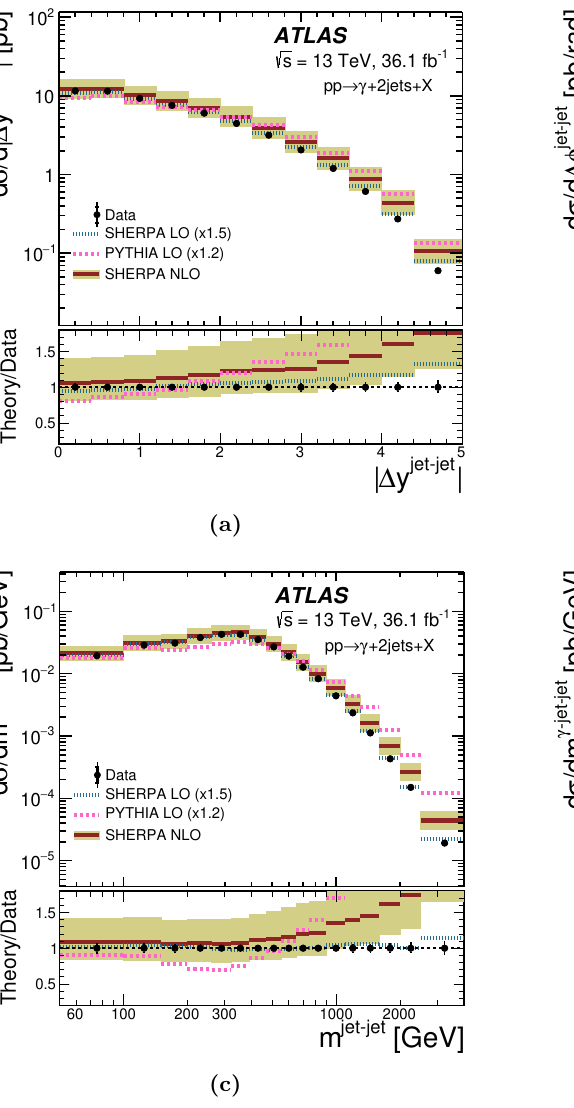
Figure 5 . Measured cross sections for isolated-photon plus two-jet production (dots) as functions of (a) j (cid:1) y jet{jet j , (b) (cid:1) (cid:30) jet{jet , (c) m jet{jet and (d) m (cid:13) {jet{jet for the total phase space. The NLO QCD predictions from Sherpa (solid lines) based on the NNPDF3.0 PDFs are also shown. The tree-level plus parton-shower predictions from LO Sherpa (dotted lines) and Pythia (dashed lines) normalised to the integrated measured cross section (using the factors indicated in parentheses) are also shown. The bottom part of each (cid:12)gure shows the ratio of the predictions to the measured cross section. The inner (outer) error bars represent the statistical uncertainties (the statistical and systematic uncertainties added in quadrature) and the (cid:12)lled bands represent the theoretical uncertainty of the NLO QCD predictions. For most of the points, the inner and outer error bars are smaller than the marker size and, thus, not visible. The visible thin error bars represent the outer error bars.